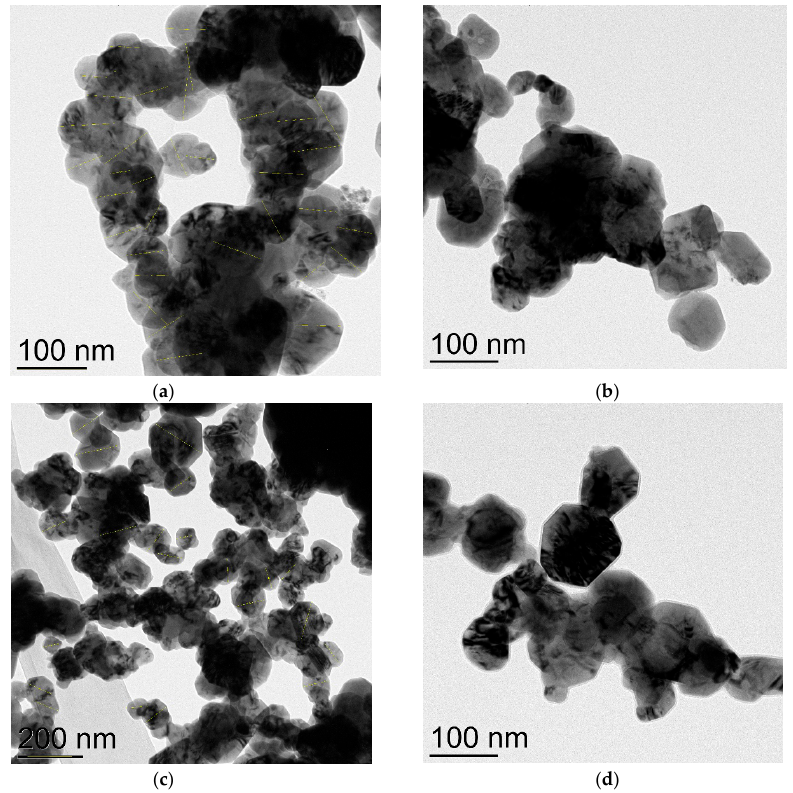
Figure 5. TEM images of Cu 2 O NPs of the average particles size 68 nm (two views, ( a , b )) and 87 nm (two views, ( c , d )). At last, the investigation of the commercial CuO nanoparticles with claimed size “<50 nm” revealed that their average size is in fact ca. 65 nm (Figure 6), they are well isolated, possess stretched shape, and electronogram verified the composition CuO with monoclinic C2/c lattice (Figure S7). Figure 6. TEM image of CuO NPs of the average particles size 65 nm.